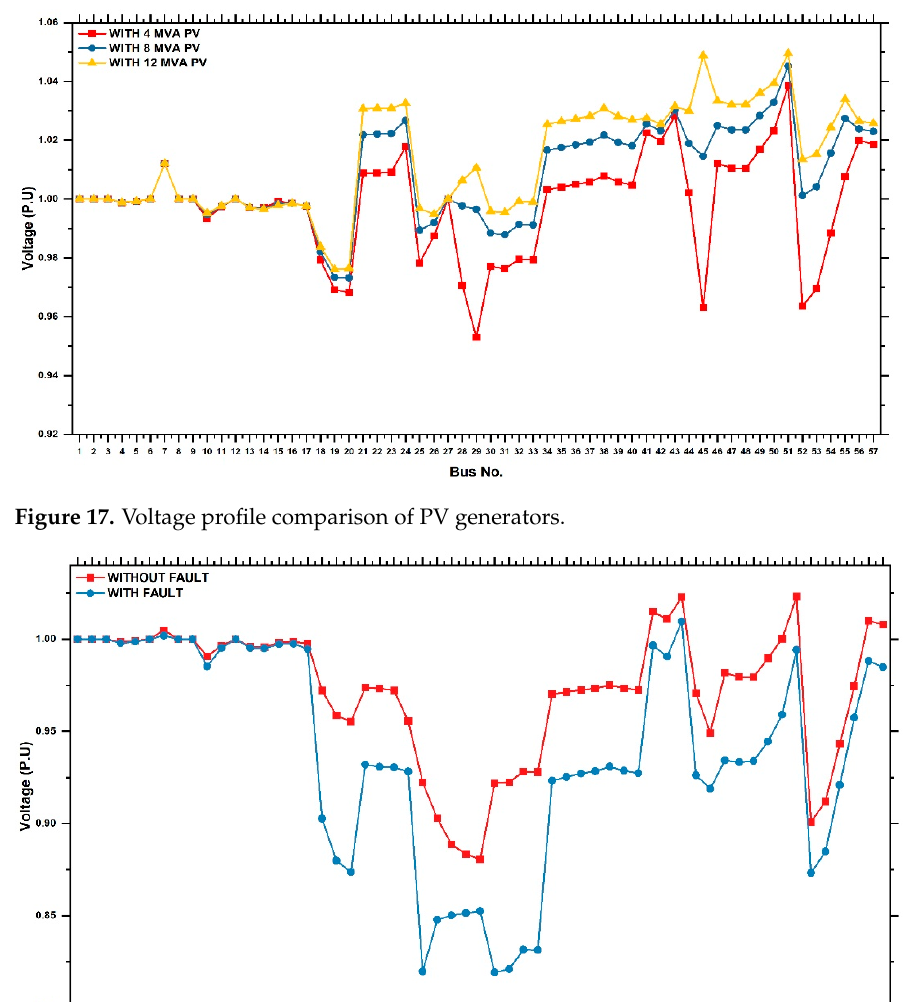
Figure 17. Voltage profile comparison of PV generators.